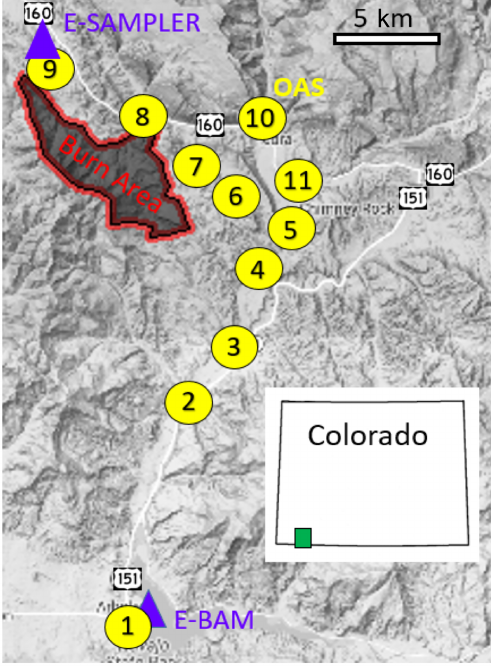
Figure 3. Location of monitoring equipment with respect to the prescribed fire. OAS (yellow circles), US Forest Service equipment (blue triangles), prescribed fire (shaded black area with red outline). Map elements created using ggplot (Kahle and Wickham,